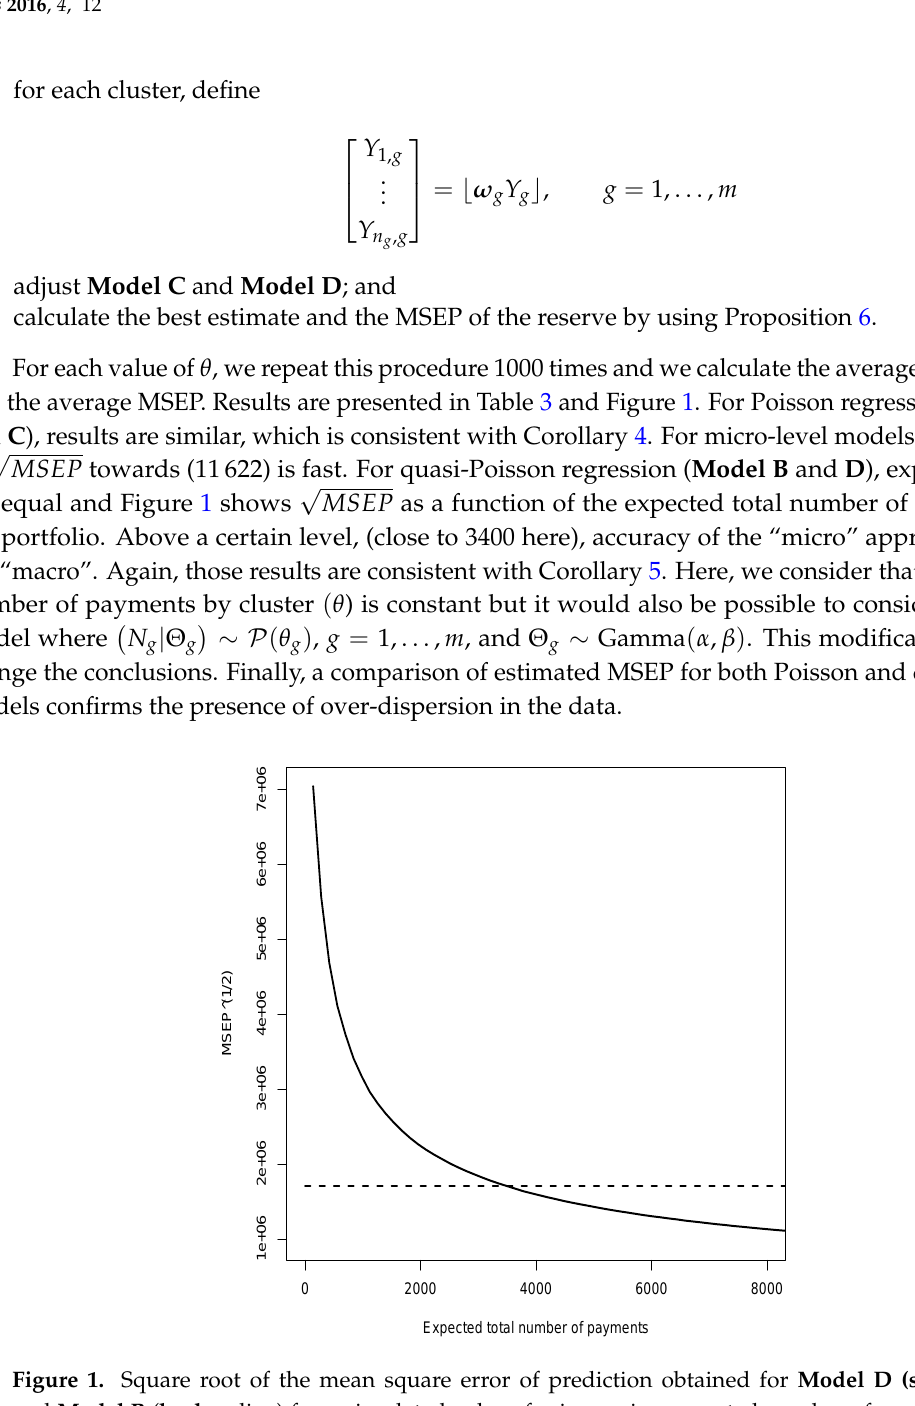
Figure 1. Square root of the mean square error of prediction obtained for Model D (solid line) and Model B ( broken line) from simulated values for increasing expected number of payments for the